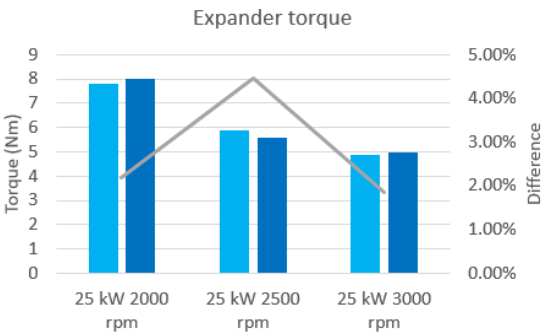
Figure 12. Validation of 3000 rpm.